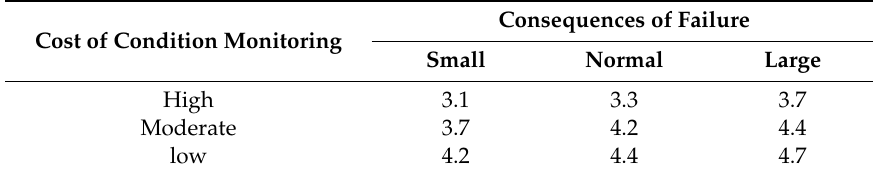
Table 3. Acceptable annual reliability index, ∆ β